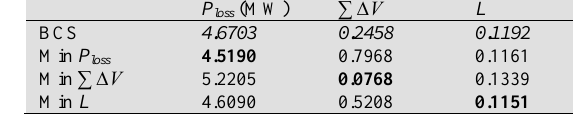
Table 4. Best compromise solution (BCS) and minimum value for each objective function